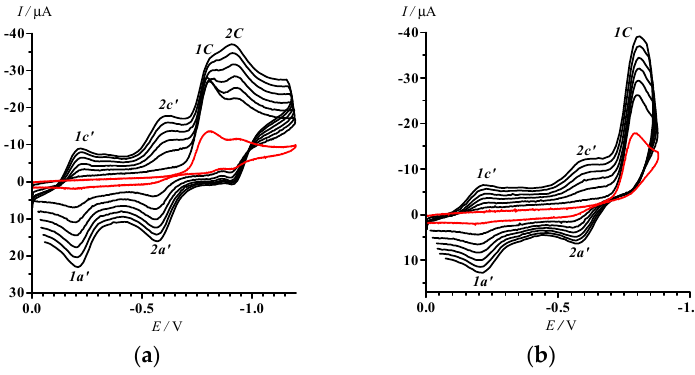
Figure 3. CVs of 13 in MeCN with potential sweep ranges 0 > E > − 1.2 ( a ) and 0 > E > − 0.88; ( b ) V. Potential sweep rates were 50 (first cycle, red curve), 250, 450, 650. 850, 1050, and 1250 (2–7 cycles, black curves) mV·s –1 .